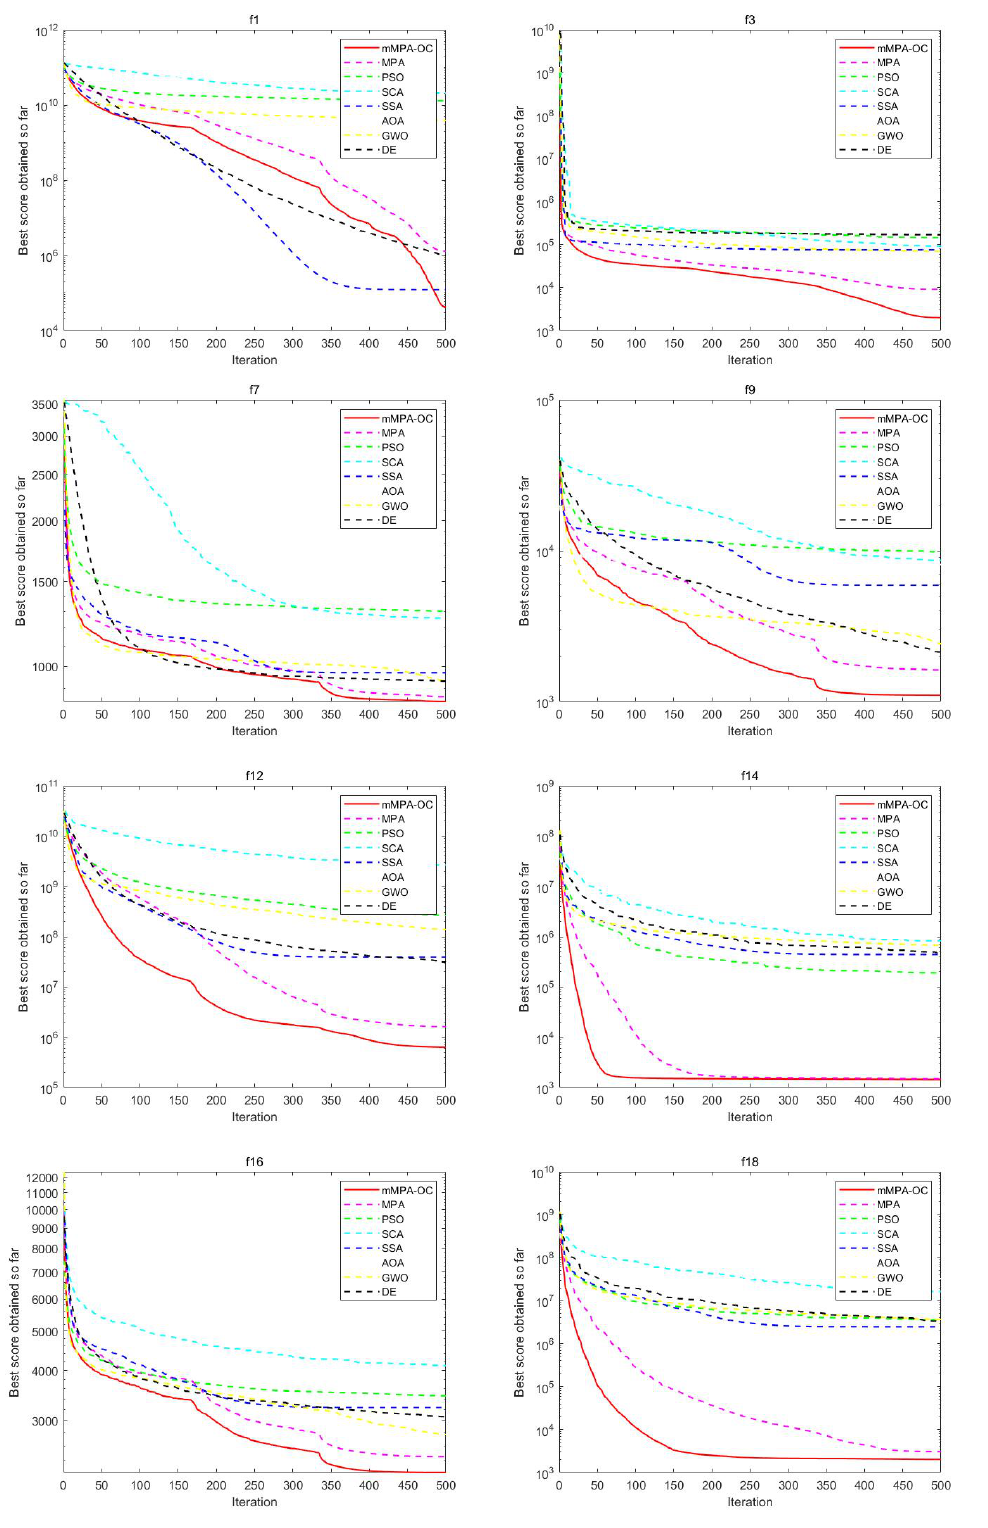
Figure 3. Convergence curve of CEC-2017 test function (30